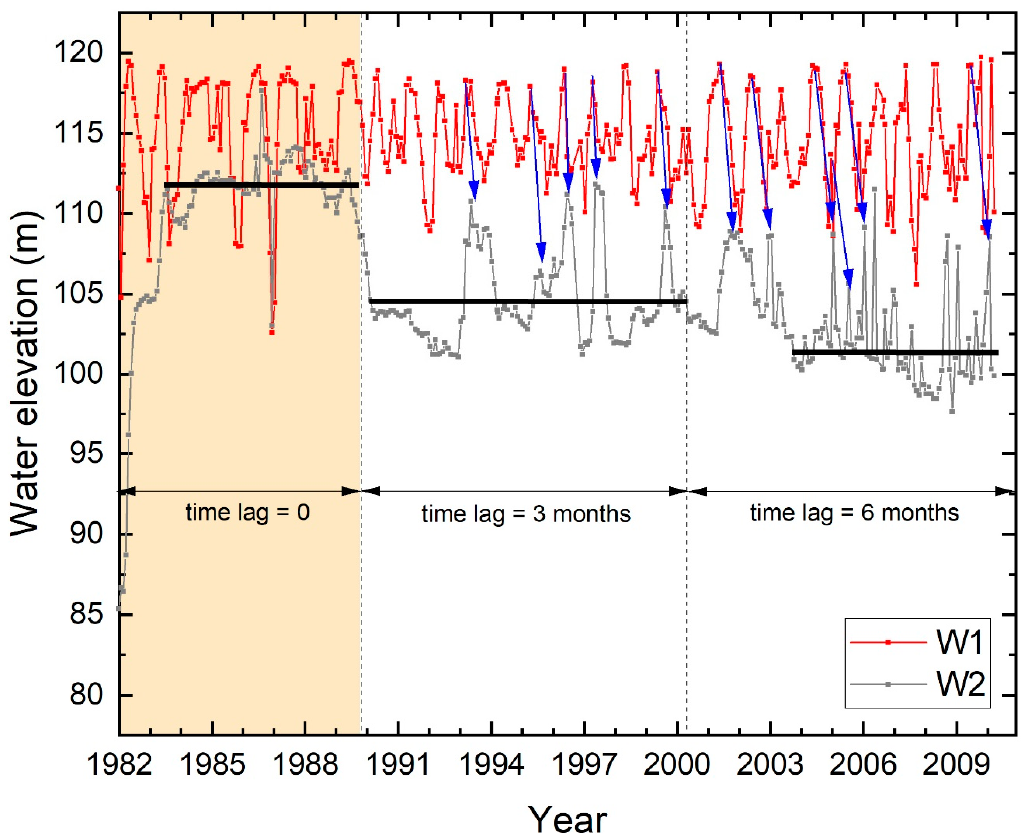
Figure 14. Hydraulic head in W1 and W2 between 1982 and 2010. Horizontal thick black lines represent the mean value of the hydraulic head in W2 during periods 1983–1989, 1990–2001, and 2003–2010. The dashed lines indicate the approximate time periods when the time lag between W1 and W2 changes. The blue arrows are connecting corresponding peaks between W1 and W2. These peaks, when aligned, result in maximum correlation between sections of data. The time difference between corresponding peaks is equal to the time lag between W1 and W2 for that section of data.